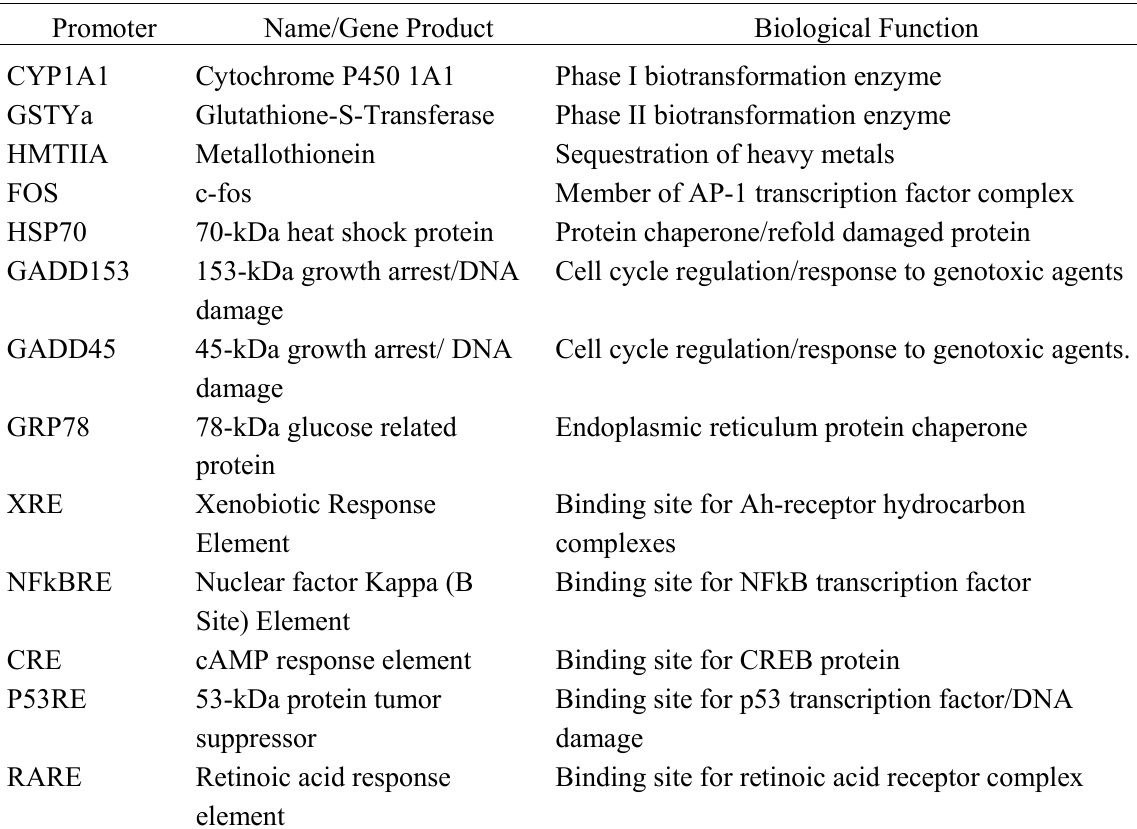
Table 1. Promoter/Response Element Fusions Constructs and Biological